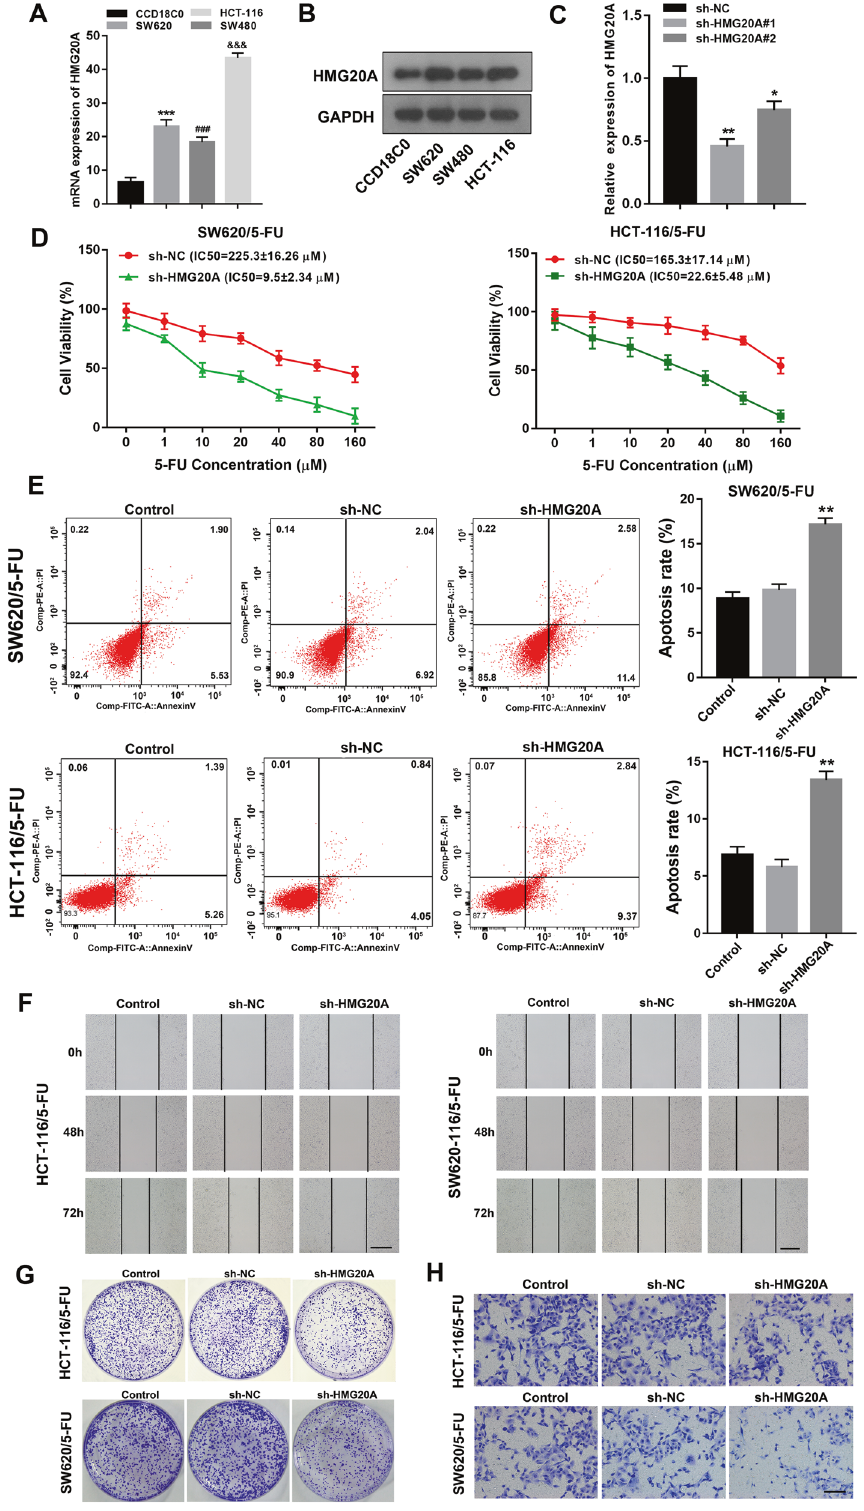
Fig. 5 HMG20A drives 5-FU resistance and CRC proliferation, migration and invasion. The mRNA ( A ) and protein ( B ) expression of HMG20A in human colorectal epithelial cells CCD18C0 and CRC cell lines HCT-116, SW620 and SW480. C Expression levels to determine the ef fi ciency of HMG20A knockdown by qRT-PCR. * P < 0.05, ** P < 0.01. D Cell viability with indicated concentrations in HCT116/5-FU and SW620/5-FU after sh-NC or sh-HMG20A treatment by MTT assay. E Flow cytometry assay to measure apoptosis in HCT-116/5-FU and SW620/5-FU cells transfected with sh-NC or sh-HMG20A. F Wound scratch assay to measure migration in HCT-116/5-FU and SW620/5-FU cells transfected with sh-NC or sh-HMG20A. G Colony formation assay to measure proliferation in HCT-116/5-FU and SW620/5-FU cells transfected with sh-NC or sh-HMG20A. H Transwell assay to measure invasion in HCT-116/5-FU and SW620/5-FU cells transfected with sh-NC or sh-HMG20A.